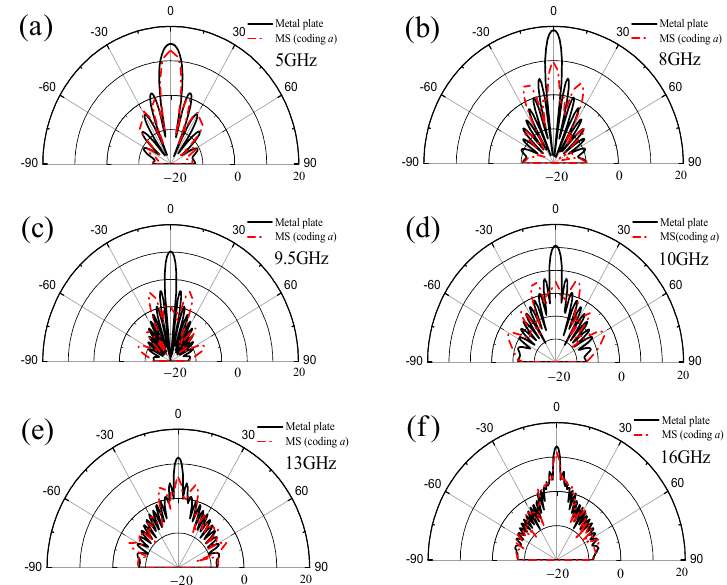
Figure 6. 2D scattering patterns of the coding a and metal plate in the xoz -plane at: ( a ) 5 GHz; ( b ) 8 GHz; ( c ) 9.5 GHz; ( d ) 10 GHz; ( e ) 13 GHz; and ( f ) 16 GHz.